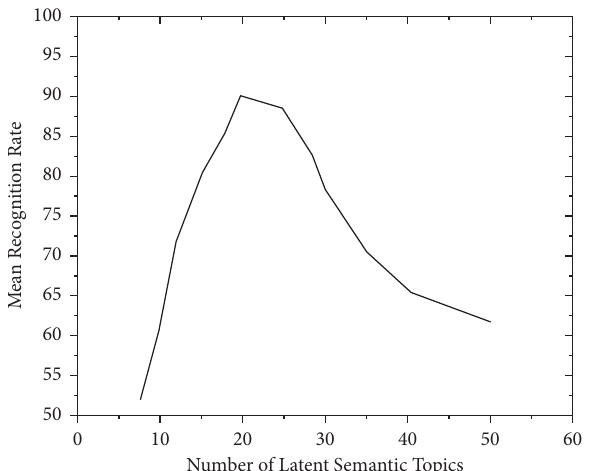
Figure 3: The effect of different number of potential semantic topics on recognition results.